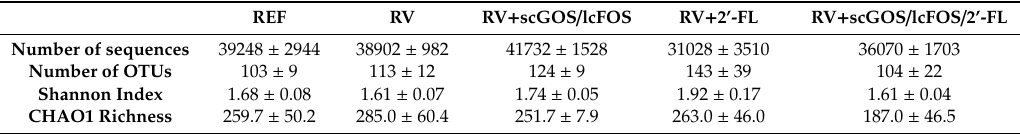
Table 1. Overall diversity of fecal microbiota at the peak of diarrhea (day 8).